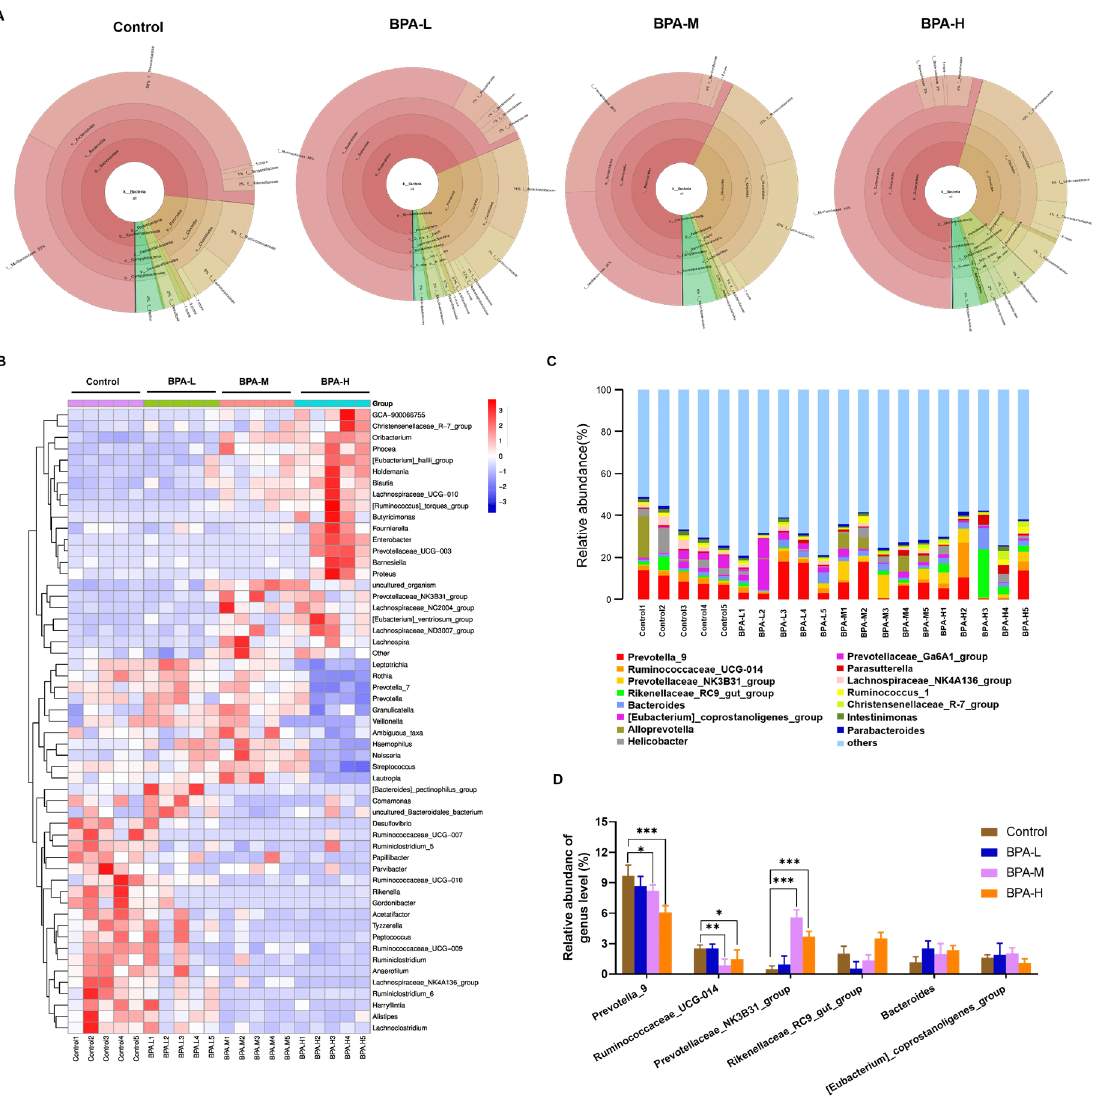
Figure 6. Relative abundance of microbial species at the genus level of rats’ feces. ( A ) Relative abun- dance of bacteria at different levels displayed using Krona. ( B ) The difference in feces bacterial struc- ture at the genus level among different groups. ( C ) The top 15 species of each group in terms of maximum abundance on the genus level. ( D ) The higher bacterial community at the genus level in rats. Data are shown as mean ± SEM. * p < 0.05, ** p < 0.01, *** p < 0.001 vs. Control group .